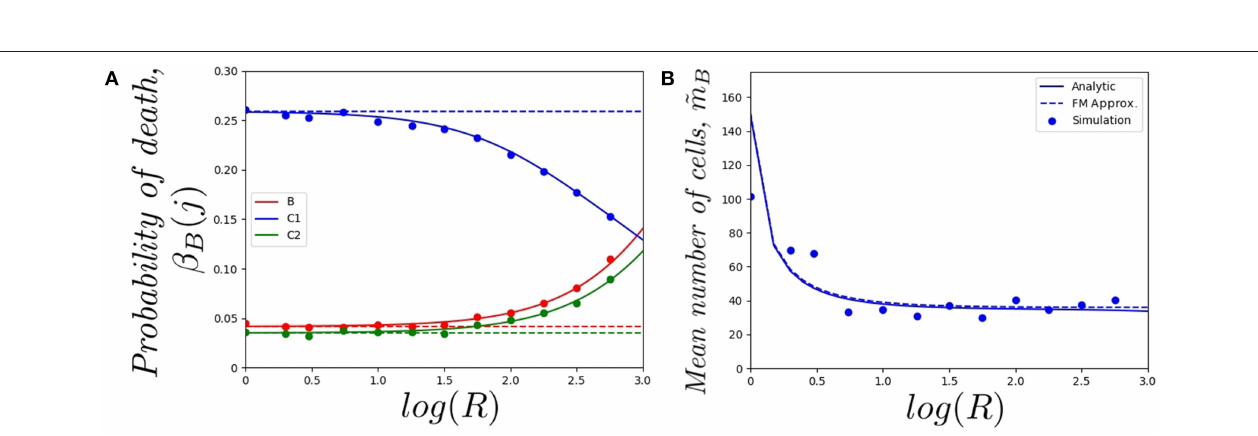
FIGURE 5 | Effect of changing the value of R on (A) the probability of the cell dying in compartment j , for j ∈ { B , C 1 , C 2 } , and (B) the mean total number of cells in the genealogy of the original cell, ˜ m B = IE( G B ). We consider a single cell starting in the blood. Analytic result ( solid ), fast-migration approximation ( dashed ) and 10 4 , for (A) , and 10 3 , for (B) , stochastic simulations ( dots ).